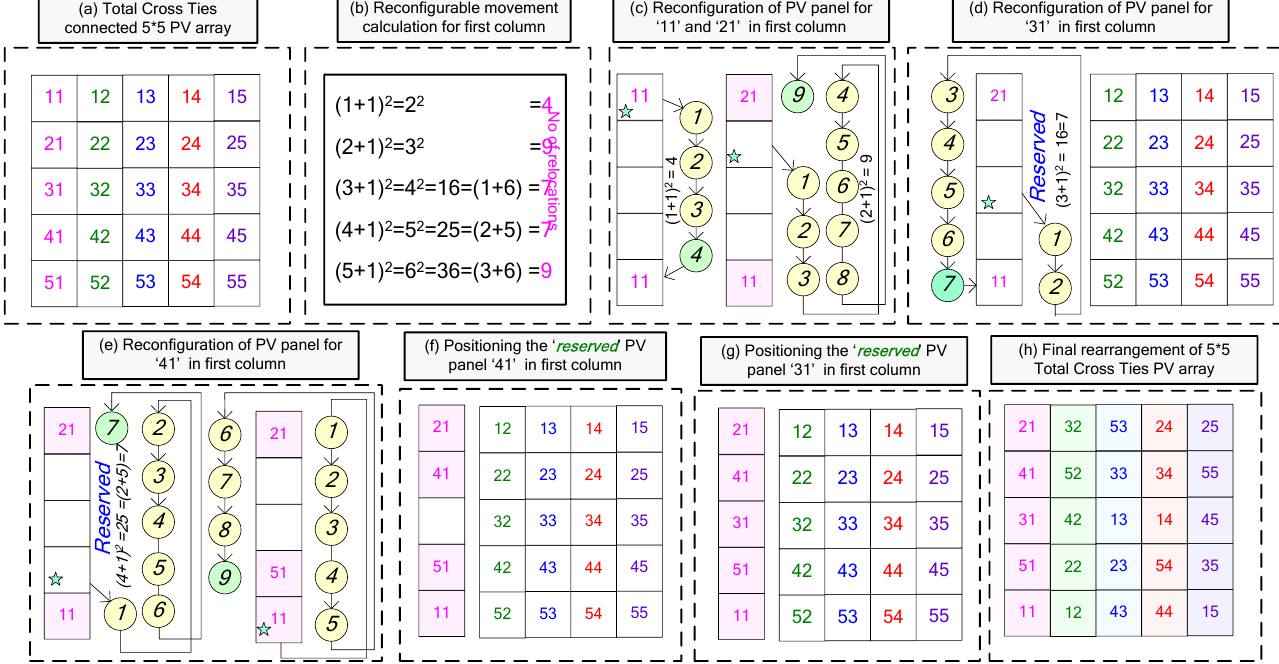
Figure 2. Reconfiguration process with position square method — Application to 5 × 5 PV array.